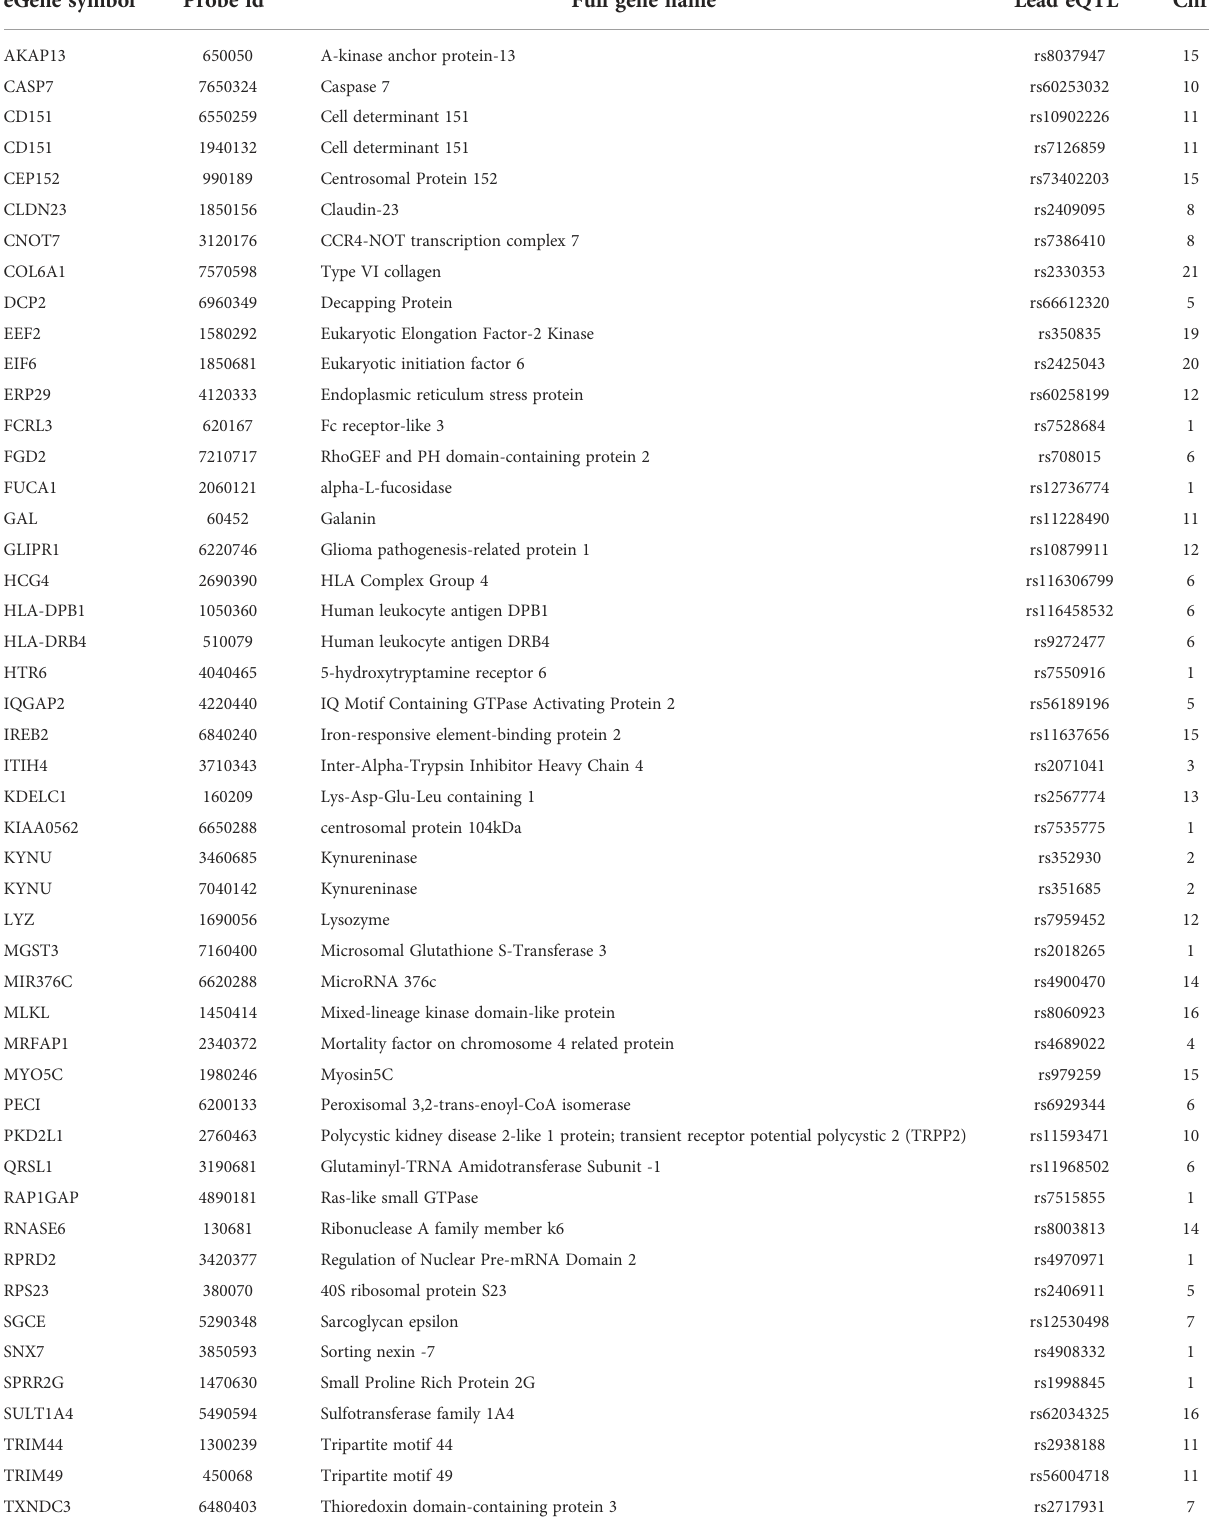
TABLE 4 eGenes with decreased expression in women with endometrial infection, and their corresponding cis-eQTLs and chromosomal locations (mediation test FDR a <0.2). eGene